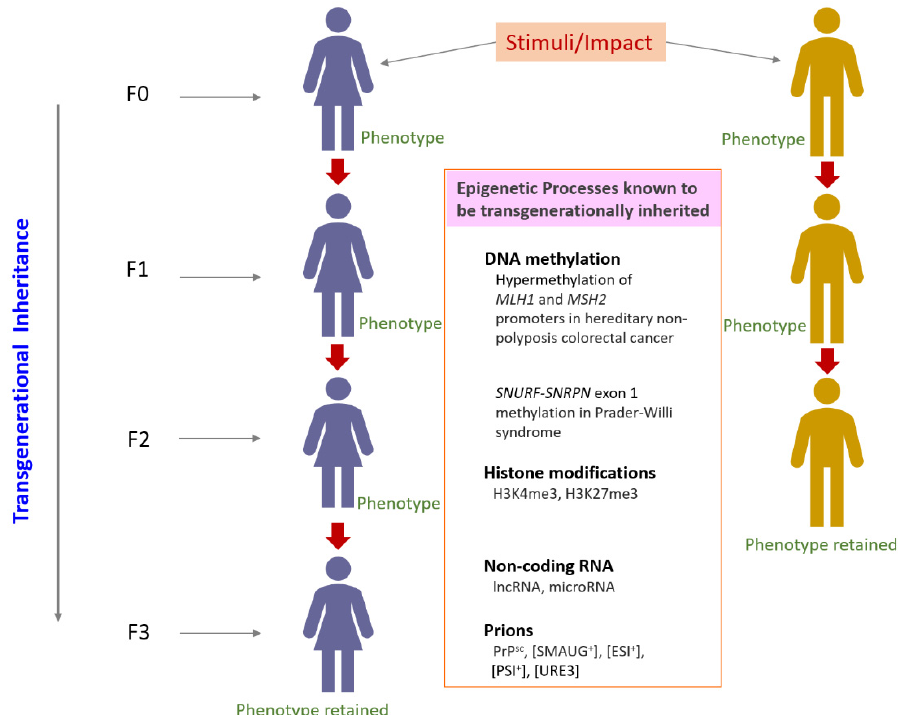
Figure 2. Transgenerational epigenetic inheritance and some phenomena reported in humans in the context of disease. MLH1 [138], MSH2 [139], SNURF-SNRPN [140], H3K4me3 and H3K27me3 [23,141,142].